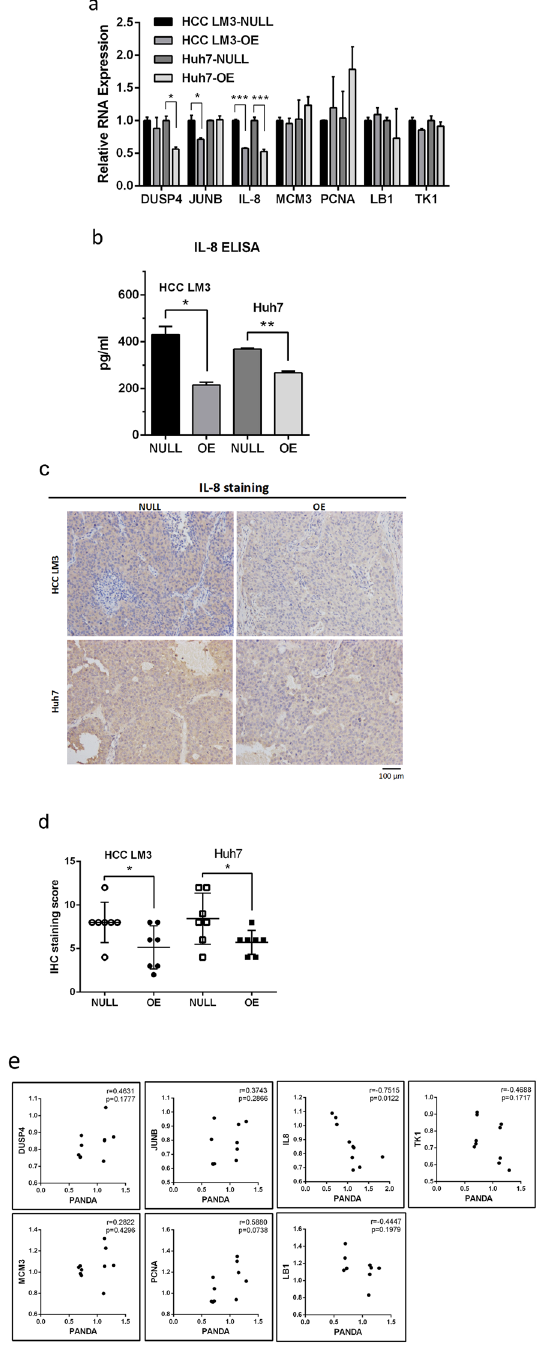
Figure 5. Overexpression of PANDA inhibits senescence associated factor IL8. ( a ) The transcriptional target genes of PANDA-PRC complexes were examined by qRT-PCR in both PANDA-overexpressing groups (OE) and control groups (NULL). ( b ) Cells in OE group secreted less IL8 into culture supernatant comparing with NULL group. ( c ) IL8 staining in xenograft model samples generated by OE cells were stronger than those of NULL cells. ( d ) IHC staining scores were analyzed. ( e ) The clinical relevance of PRC target genes and lncRNA PANDA were analyzed in a small number of patients in cohort